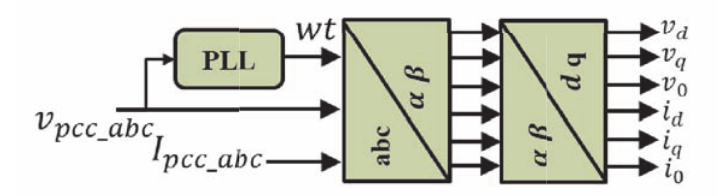
Fig. 3. Converting the measured current and voltage to dq -frame. Fig. 3.